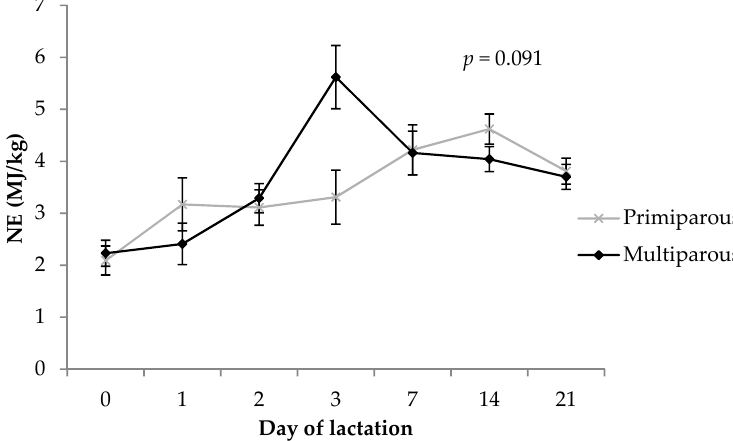
Figure 5. Comparison of calculated NE (MJ/kg) in colostrum and milk between primiparous and multiparous sows. The p- value stated is the effect of the parity by timepoint interaction. Error bars represent the standard error of the mean (± SEM).